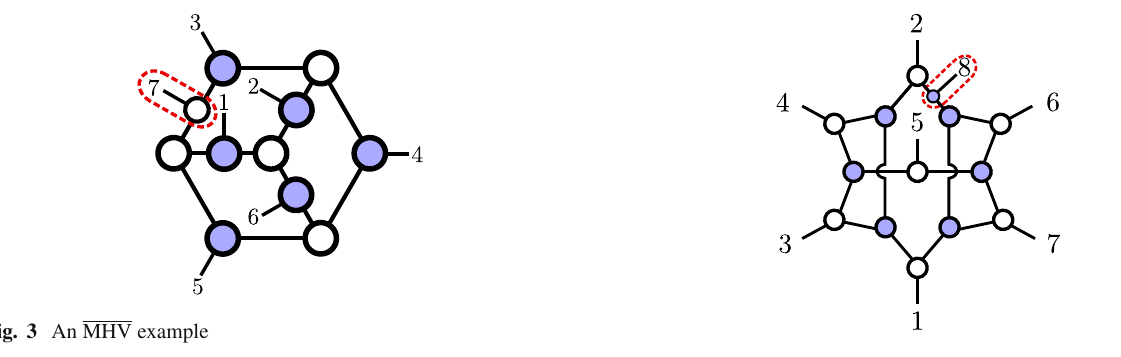
Fig. 4 A non-planar NMHV 4-loop leading